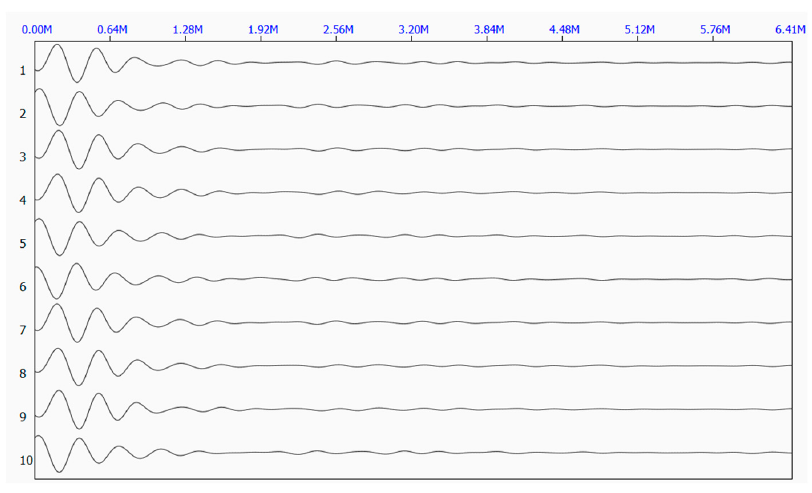
Figure 10. Original waveforms of the reflected stress wave at Site 1.